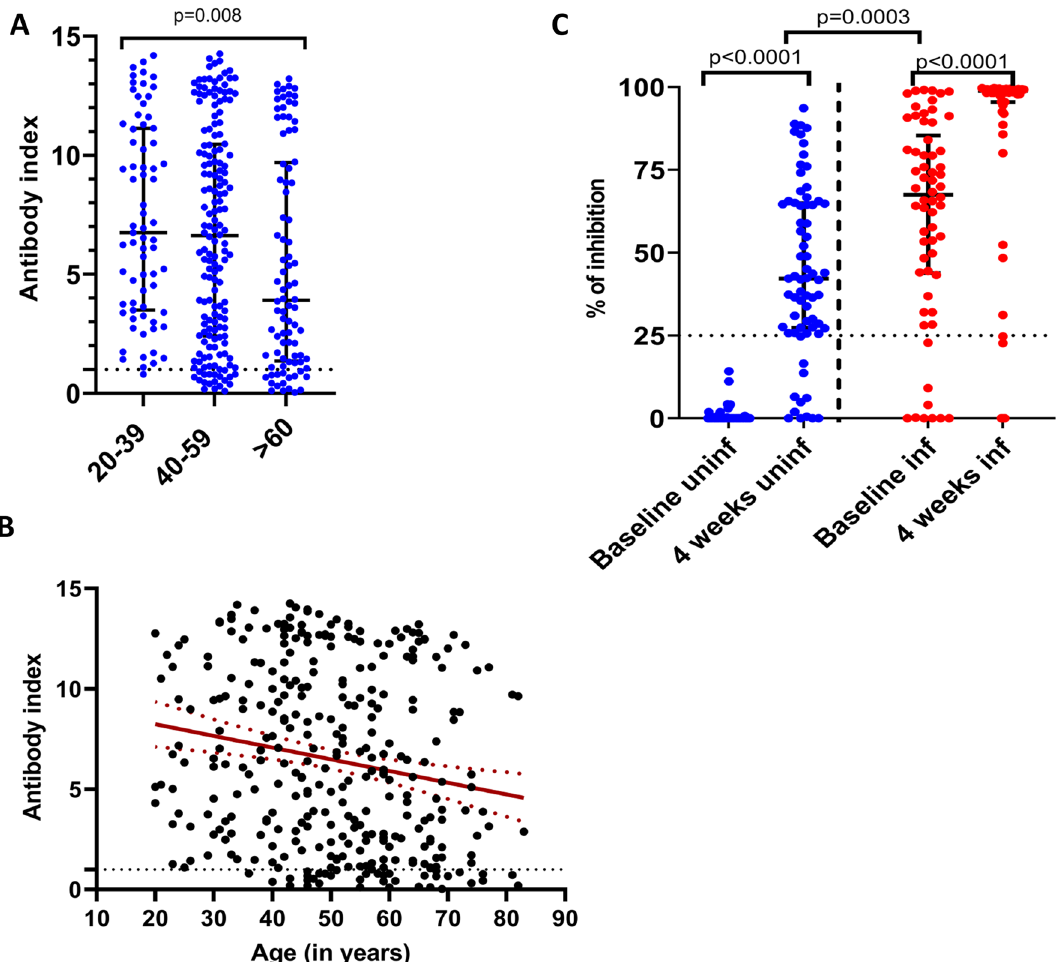
Figure 1. SARS-CoV-2 total antibodies and ACE2 receptor blocking antibodies in individuals 4 weeks after the first dose of Gam-COVID-Vac. The SARS-CoV-2 total antibody levels (antibody index values) were measured using the WANTAI SARS-CoV-2 Antibody ELISA assay in those between 20 to 39 years (n = 71), 40 to 59 years (n = 168) and 60 years (n = 88) ( A ) and the antibody levels were correlated with the age of individuals (n = 327), Spearman’s r = −0.21, p = 0.0001 ( B ). ACE2 receptor blocking antibodies were measured by the surrogate neutralizing antibody assay in a sub-cohort of baseline uninfected individuals (n = 69, blue) at 4 weeks and in a cohort of baseline infected individuals (n = 62, red), who were found to be seropositive for SARS-CoV-2 at the time of recruitment ( C ). The differences in the total antibody titres between different age groups was determined by the Kruskal–Wallis test. The differences in ACE2 receptor blocking antibodies at baseline uninfected and infected individuals were assessed by the Wilcoxon matched pairs signed ranked test. All tests were two sided. The error bars indicate the median and the interquartile